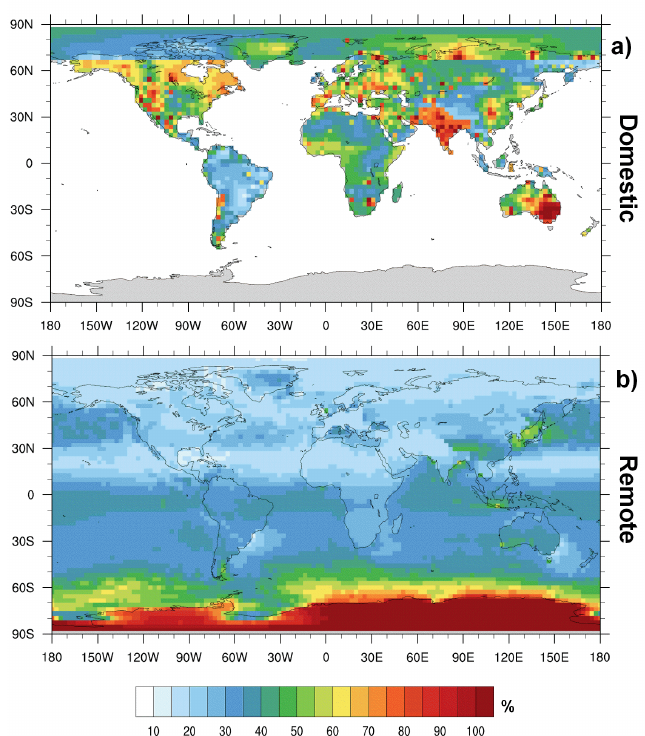
Figure 3. Normalised confidence interval amplitudes of the mean (NCIAM) Hg due to ( a ) Domestic emissions and ( b ) Remote emissions. Larger NCIAM values correspond to larger uncertainty in the estimates of the mean. Amplitudes were normalised to the mean value in each model cell, therefore values greater than 100% correspond to a total uncertainty larger than the mean value itself. Both mean and CI (at 95%) were calculated using the bootstrap method [23], starting from the ensemble of simulations reported in Table 1. The uncertainty in the Hg domestic emissions is greater than for remote emissions for almost all